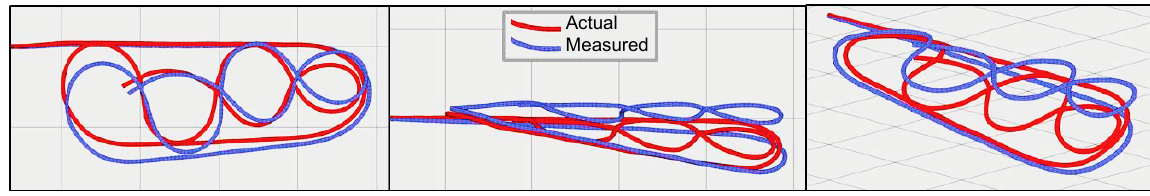
Fig. 4 | An example of multicore fiber-based shape measurement. Figure reproduced from ref. 26 , Optical Society of America.